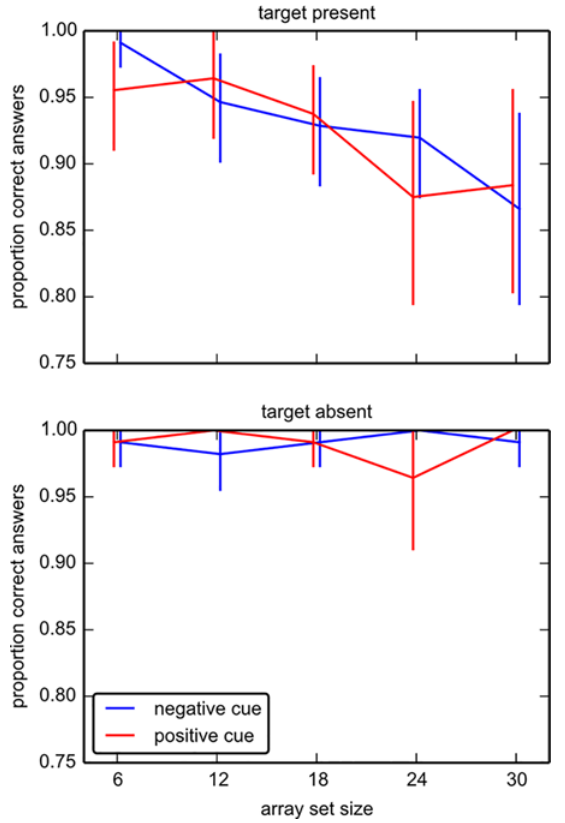
Fig 3. Correct responses in experiment 1. Target-present trials (top) and target-absent trials (bottom) in both cue types; positive (blue) and negative (red). Bars show (bootstrap) confidence intervals.